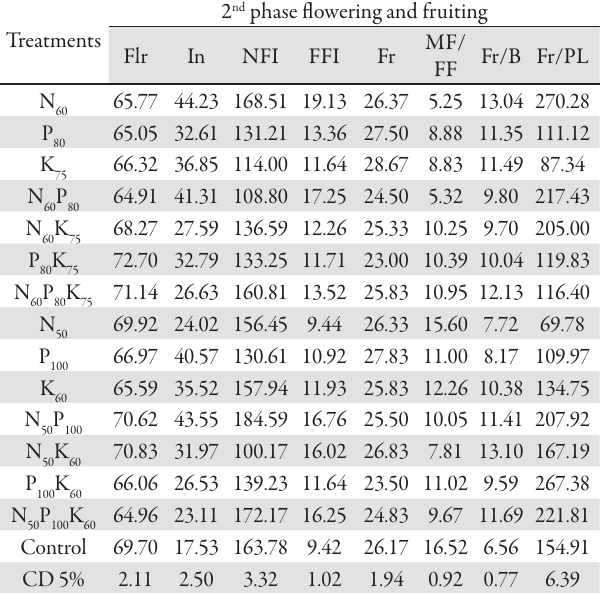
Tab. 3. Effect of N, P & K on 2nd phase flowering and fruiting of Jatropha (Pooled)